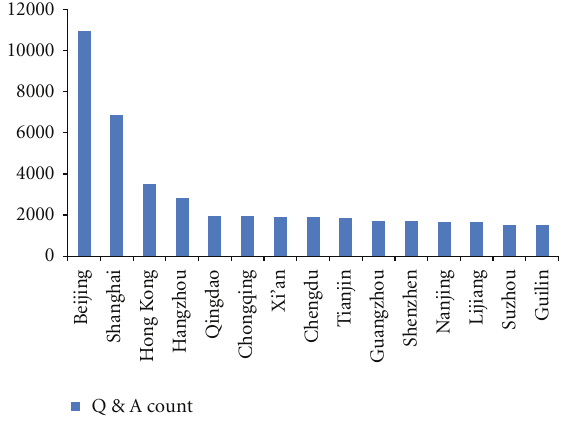
Figure 6: Top 15 cities according to Q&A count.